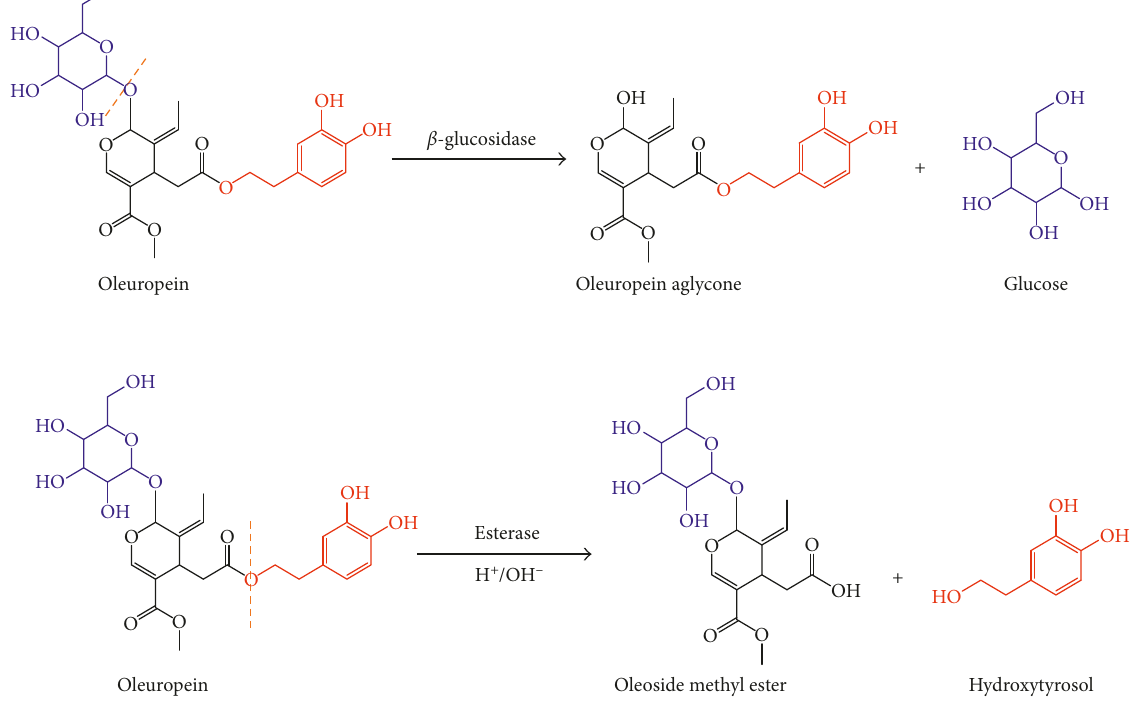
Figure 3: Mechanism of oleuropein